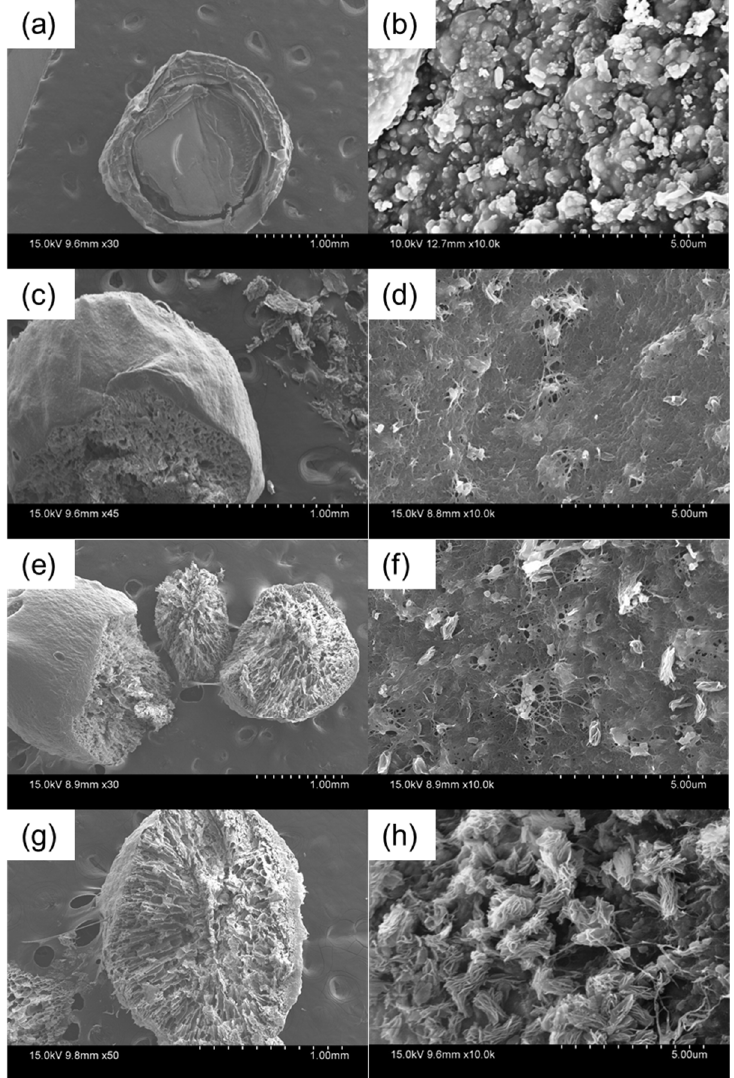
Figure 1. SEM images of ( a , b ) HGC-0, ( c , d ) HGC-1, ( e , f ) HGC-2, and ( g , h ) HGC-3 beads at different magnifications.